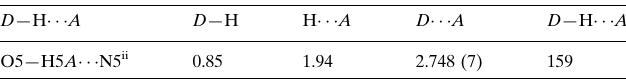
Hydrogen-bond geometry (A˚ , (cid:4)